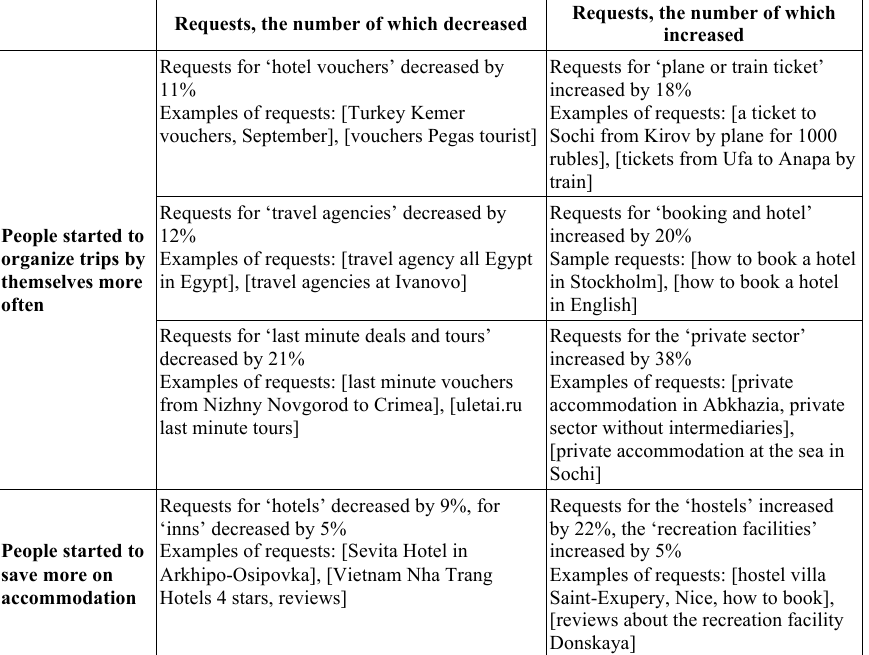
Table 1. Changes in the wording of tourist requests in 2014 and 2015 Requests, the number of which decreased